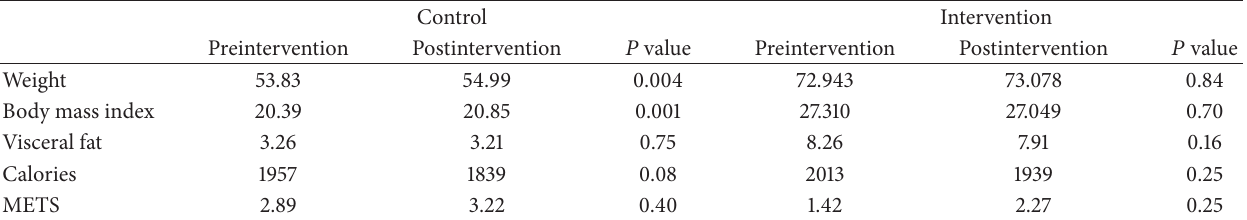
Table 2: Parameters of the two groups before and after the intervention (within group comparison).